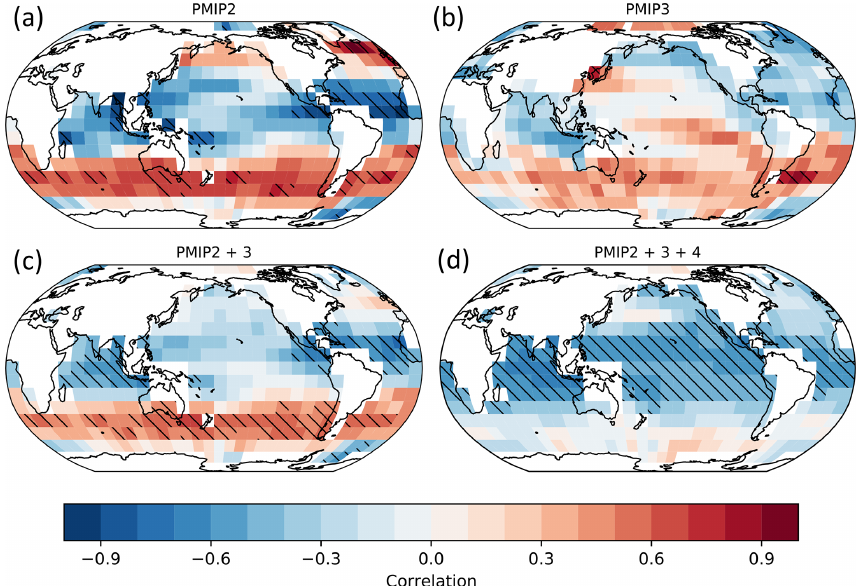
Figure 3. Correlation between SST anomaly and ECS (as in Fig. 2) in (a) PMIP2, (b) PMIP3, (c) PMIP2 + PMIP3 and (d) PMIP2 + PMIP3 + PMIP4 (CESM2.1 included) and comparison to a 10000-member permuted ensemble. If hatched, the correlation in the real ensemble at that cell is outside the 5%–95% interval of the correlation distribution of the permuted ensemble and is thus unlikely to appear by chance. Models have been regridded on 10 ◦ grids to minimize dependency between neighboring cells.